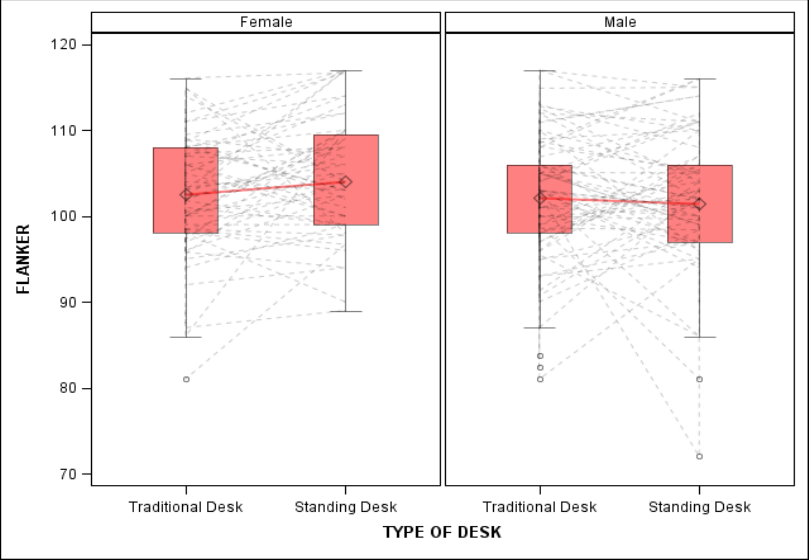
Figure 2. Flanker performance by sex between traditional and stand-biased desks. Figure shows mean flanker performance by sex. Female students in stand-biased desks showed increased flanker performance compared to their traditional desk using peers.